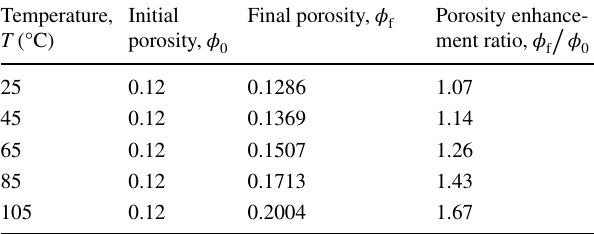
Table 2 Effect of temperature on porosity enhancement ratio